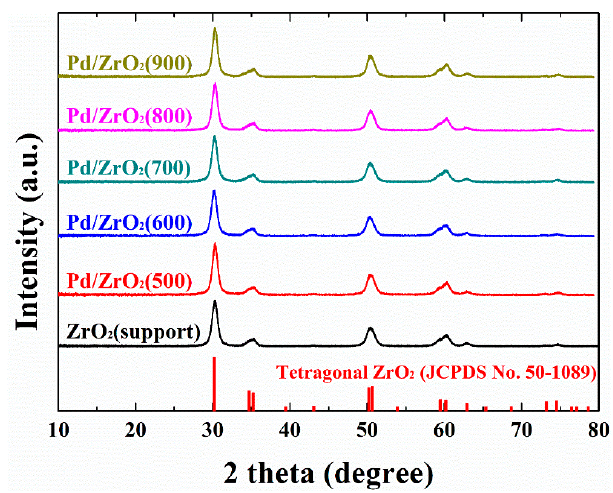
Figure 1. X-ray di ff raction (XRD) patterns of the ZrO 2 support and the Pd / ZrO 2 (x) catalysts. The ZrO 2 Figure 1. X-ray diffraction (XRD) patterns of the ZrO 2 support and the Pd/ZrO 2 (x) catalysts. The ZrO 2 support was pre-calcined at 900 ◦ C for 6 h, then calcined at a range of di ff erent temperatures in Celsius support was pre-calcined at 900 °C for 6 h, then calcined at a range of different temperatures in Celsius degree (500–900 ◦ C) following the impregnation of Pd. degree (500–900 °C) following the impregnation of Pd.